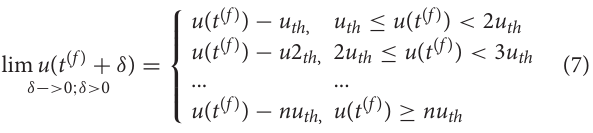
IOW LIF neurons shall also generate weighted output